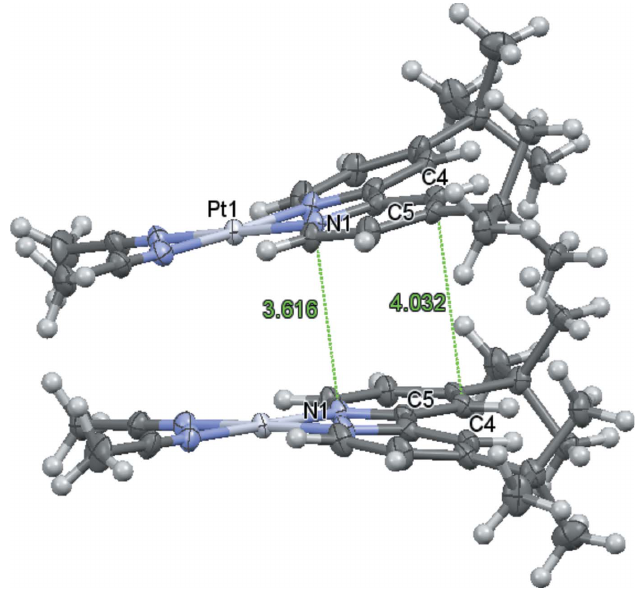
Figure 2 Displacement ellipsoid plot (50% probability of all non-H atoms), illustrating the slightly canted head-to-head dimer with selected intra- molecular distances shown.